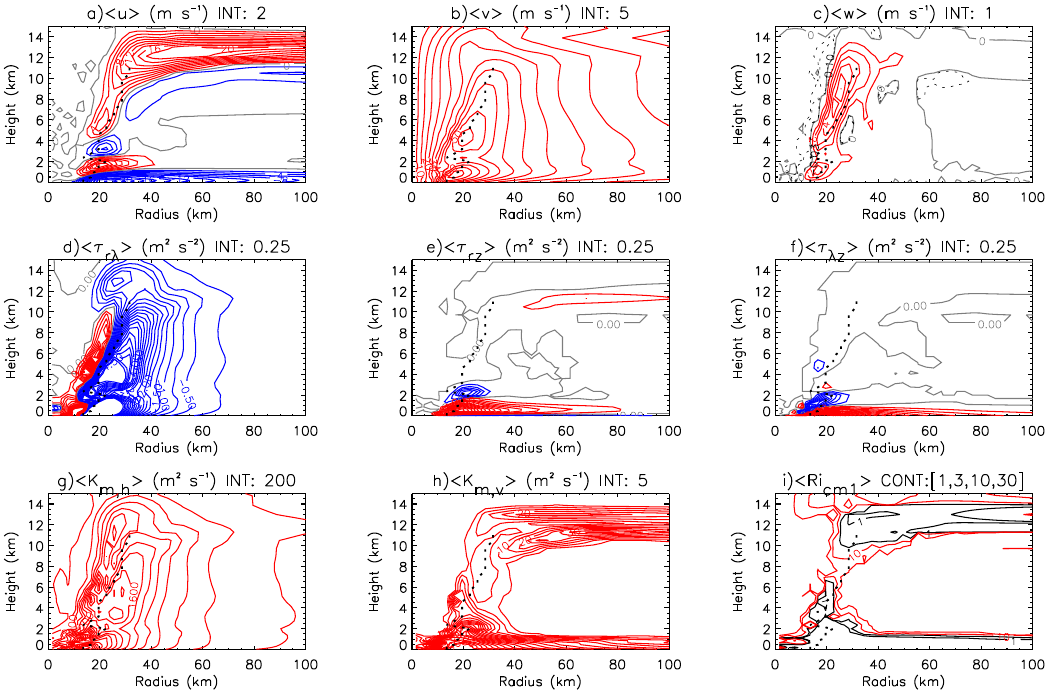
Fig. 18. Radius-height contour plots of resolved and subgrid eddy momentum fluxes and related quantities from the AX3k simulation using data at a 2-minute interval and averaged over a mature period (176 - 200 h). Except where otherwise noted, there are 20 positive red contours and 20 negative blue contours. Panel (a): h u i with contour interval 2 m s − 1 ; panel (b): h v i with contour interval 5 m s − 1 ; panel (c): h w i with contour interval 1 m s − 1 ; panel (d): subgrid momentum flux corresponding to Fig. 17d h τ rλ i with contour interval 0.25 m 2 s − 2 ; panel (e): subgrid momentum flux corresponding to Fig. 17e h τ rz i with contour interval 0.25 m 2 s − 2 ; panel (f): subgrid momentum flux corresponding to Fig. 17f h τ λz i with contour interval 0.25 m 2 s − 2 ; panel (g): horizontal diffusivity h K m,h i with contour interval 200 m 2 s − 1 ; panel (h): vertical diffusivity h K m,v i with contour interval 5 m 2 s − 1 ; panel (i): time and azimuthal average of the gradient Richardson number used in the CM1 model h Ri cm 1 i with black contours 1 and 3 and red contours 10 and 30. The radius of maximum h v i at each height is shown with the black dashed curve (up to 11 km). i; 16e, f; 17h, i; 18e, f) have the expected large